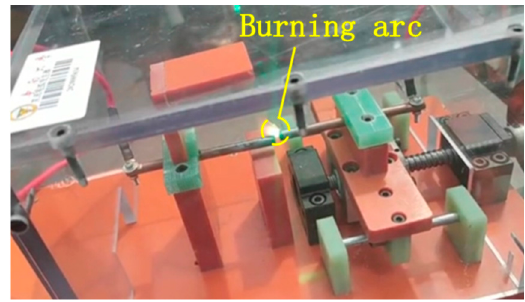
Figure 5. The shot of the burning arc .